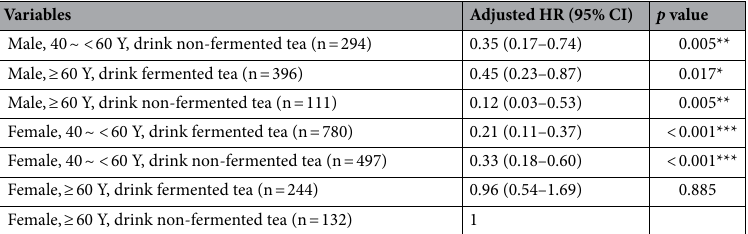
Table 2. Multivariate Cox proportional hazards regression model for osteoporosis. CI, confidence interval; HR, hazard ratio; BMI, body mass index. p < 0.05*; p < 0.01**; p < 0.001***. a Total tea drinking amount was divided by cups (200 ml). b Hazard ratio without adjusting confounding factors. c Hazard ratio adjusted for age, residential urbanicity, family history of osteoporosis, diabetes mellitus, coronary heart disease, waist circumference, hip circumference, total tea drinking amount, coffee drinking habits, regular diet > 3 meals per day, regular exercise, smoking experience, weekday sleeping time, and weekend sleeping time. d Hazard ratio adjusted for sex and all variables in footnote c, except for age. e Hazard ratio adjusted for all variables in footnote c, except for age and